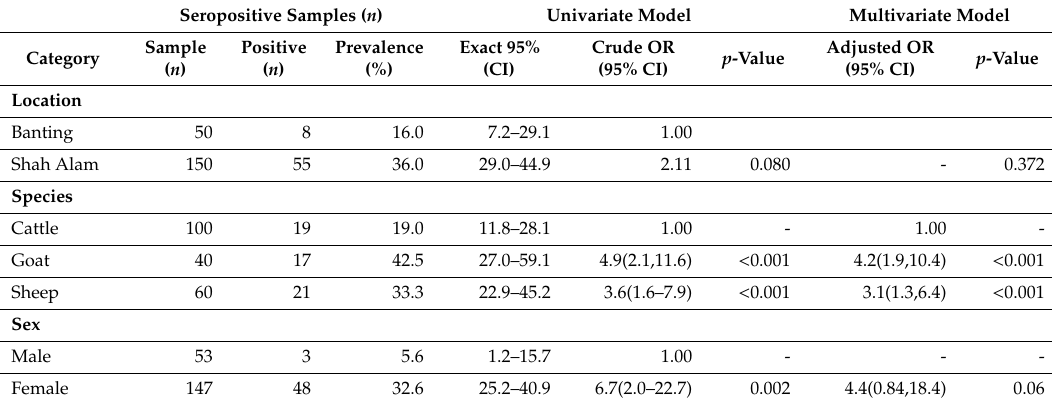
Table 5. Seroprevalence estimates with exact 95% confidence limits (CI), regression univariate and multivariate analysis for Toxoplasma gondii antibodies detected in diaphragm samples of cattle, goat and sheep purchased from abattoirs in